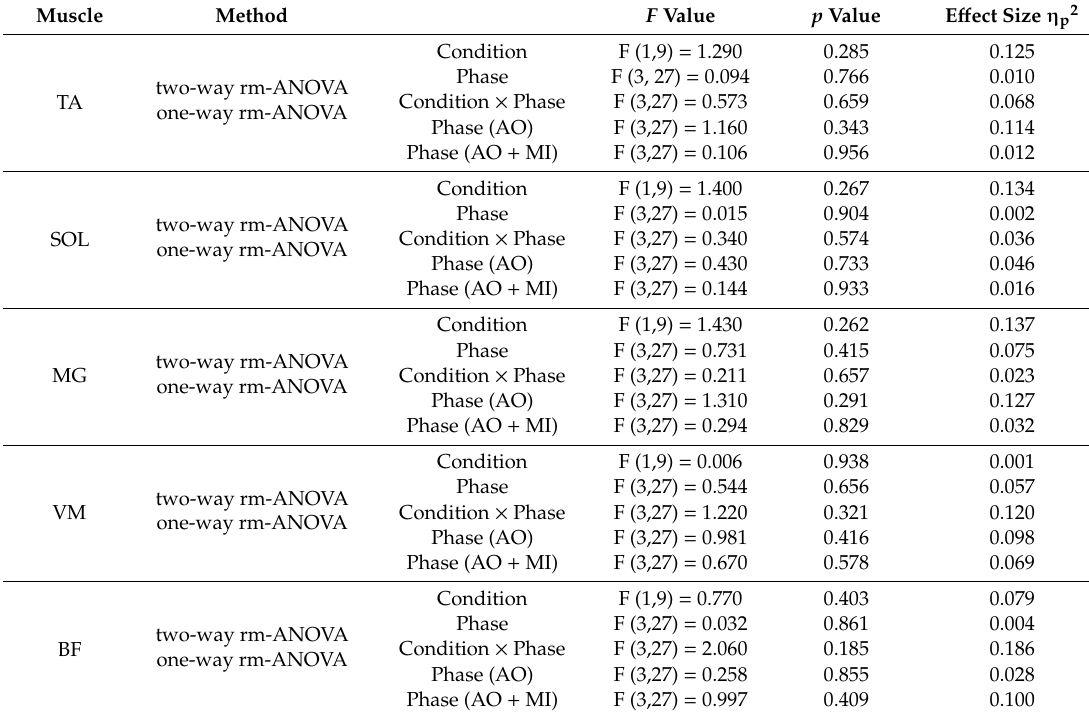
Table 2. Summary of statistical analyses comparing transcutaneous spinal cord stimulation (tSCS)-evoked reflexes between action observation (AO) and AO with motor imagery (AO + MI) conditions and among the four phases in each condition using repeated-measures (rm)-ANOVAs. Muscle